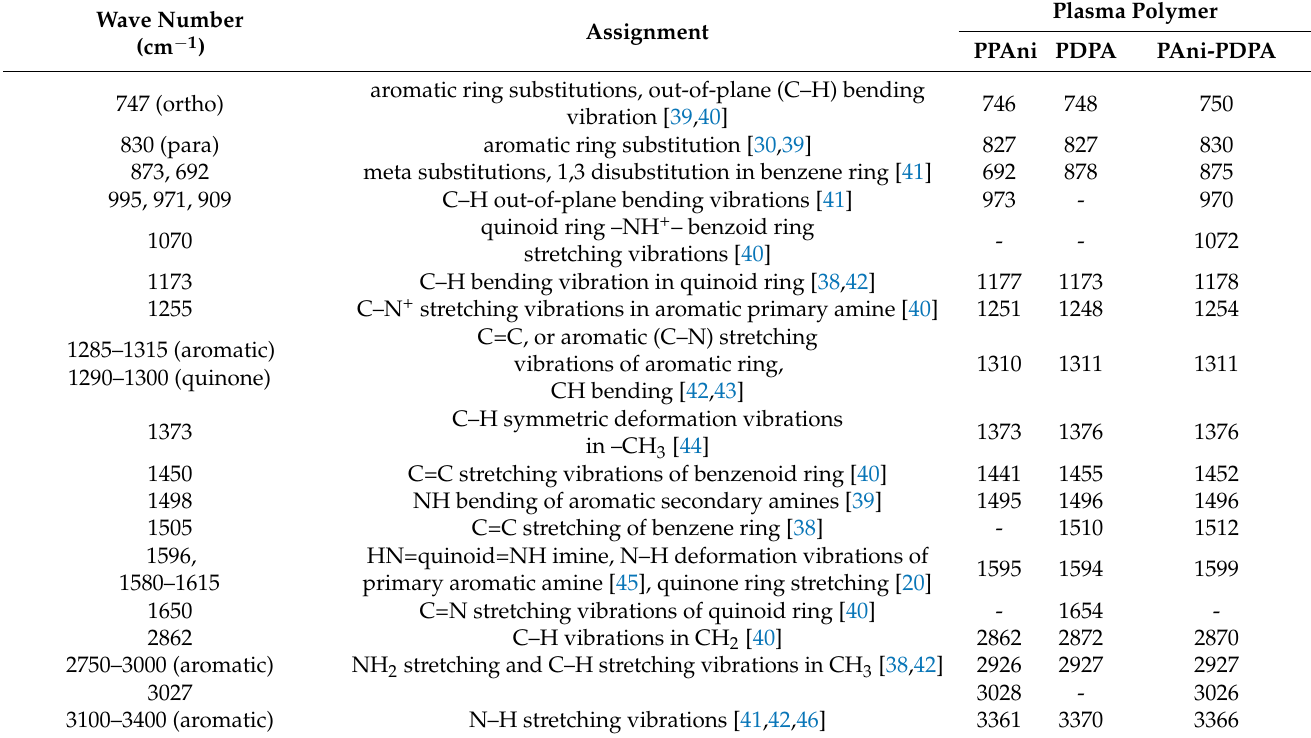
Table 2. FT-IR absorption frequencies for PPAni, PDPA, and